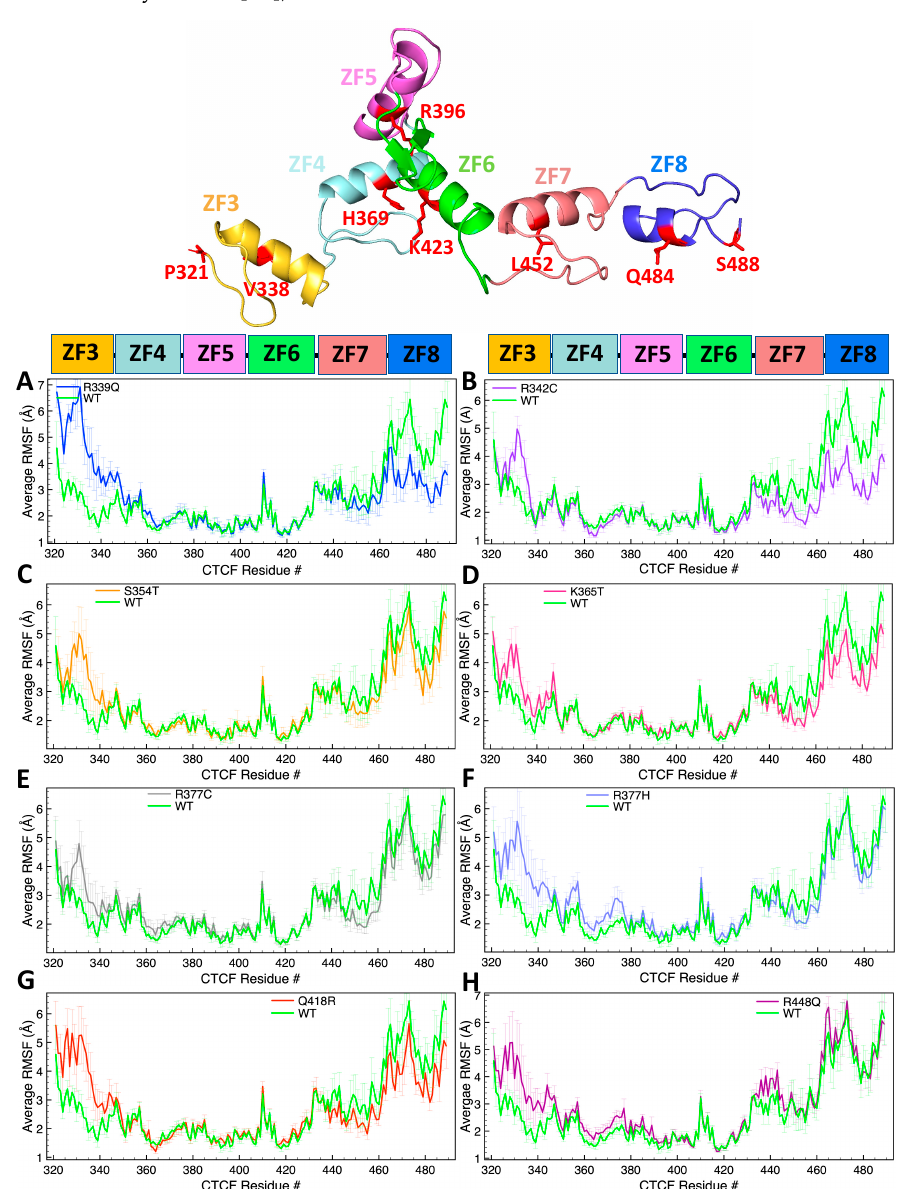
Figure 2. Single-residue mutations alter the average RMSF per residue of CTCF. Panels compare the wildtype system (green curve) to: ( A ) R339Q; ( B ) R342C; ( C ) S354T; ( D ) K365T; ( E ) R377C; ( F ) R377H; ( G ) Q418R; and ( H ) R448Q. The residue position of each zinc finger is shown at the top (ZF3 321–348; ZF4 349–376; ZF5 377–404; ZF6 405–434; ZF7 435–464; and ZF8 465–489). RMSF values are calculated by averaging the RMSF of each of the five replicas. Error bars represent the standard error.